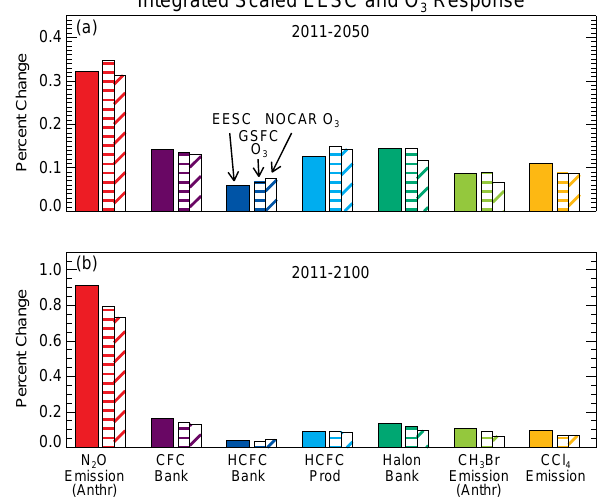
Fig. 5. Correlation of integrated EESC changes (3y mean age) with integrated globally averaged total column ozone changes over the period 2011–2050. Ozone values are calculated by the GSFC (filled diamonds) and NOCAR (squares) models. The linear fits of the cases shown are also included (solid for GSFC; dashed for NOCAR). These fits are forced to go through the origin and do not include the N 2 O case (red symbols) in their calculation. The NO- CAR slope (dashed blue) is less negative than the GSFC slope (solid black) primarily due to a smaller ozone change in the NOCAR bromine cases (green squares) than would be expected with an α of 60. The inset shows the same information as the main figure with the scales expanded so the N 2 O emission phaseout case (red symbols) is visible.